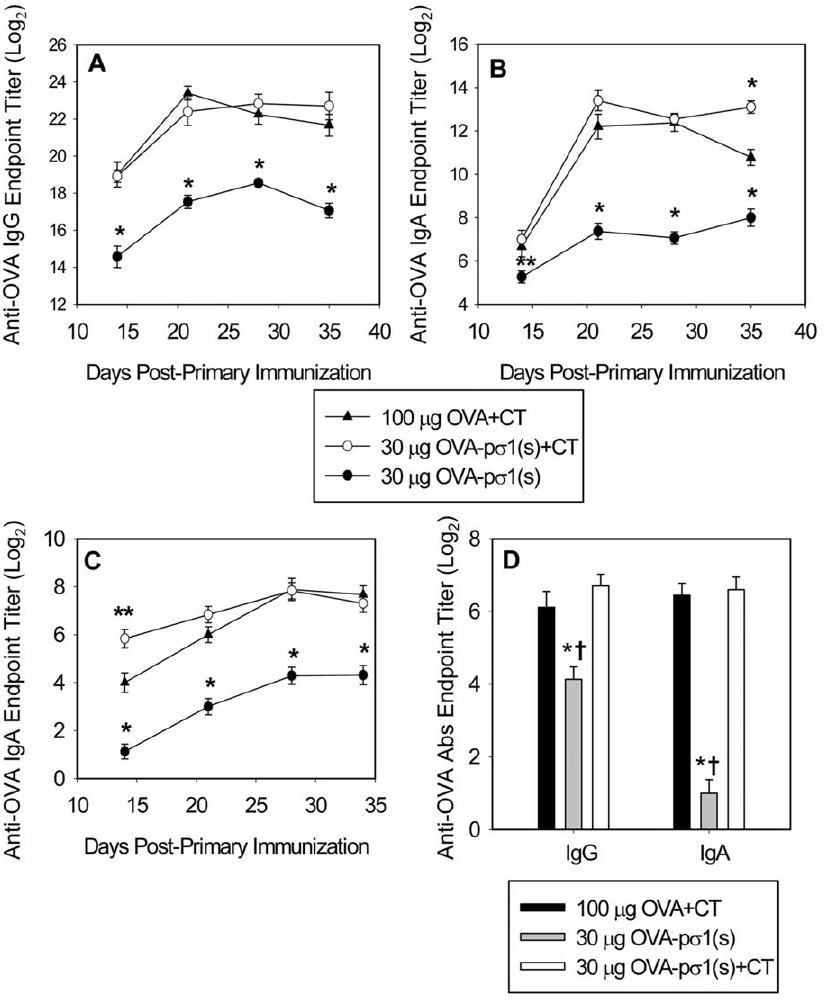
Figure 5. OVA-p s 1(s) is 5 times more effective per molar basis than native OVA in stimulating immune Abs. Groups of C57BL/6 mice (9/ group) were immunized nasally with 30 m g OVA-p s 1(s) alone, 30 m g OVA-p s 1(s) plus cholera toxin (CT), or 100 m g OVA plus CT using the vaccination schedule described in Fig. 4. A.–D. Although mice immunized with OVA-p s 1(s) alone consistently produced less Ag-specific Abs, CT co- administration enhanced anti-OVA endpoint titers than the 100 m g OVA plus CT-immunized group: A. serum IgG, B. serum IgA, C. fecal IgA, and D. day 35 nasal wash IgA and IgG endpoint anti-OVA Ab titers. A kinetic analysis of the indicated time points is depicted from two experiments as mean 6 SEM; * P , 0.001, ** P # 0.012 versus OVA plus CT-immunized mice; and { P , 0.001 versus nasal wash titers from OVA-p s 1(s) plus CT-immunized